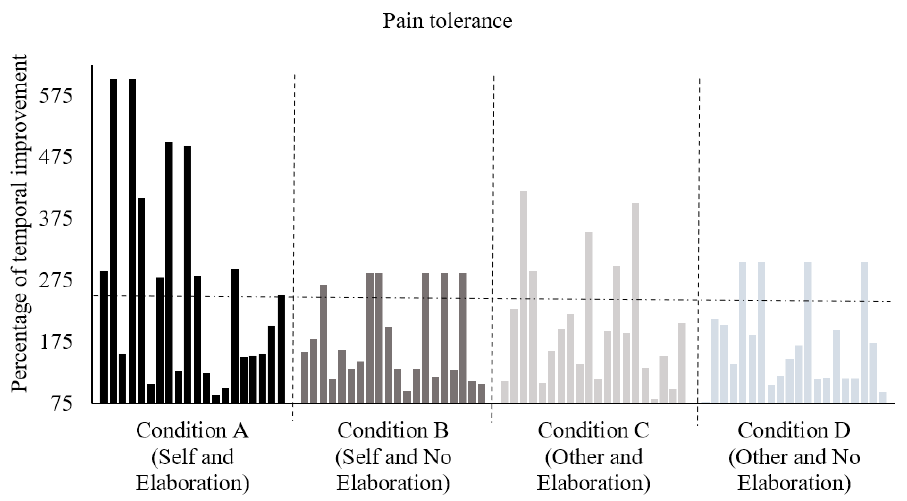
Figure 2. Percentage of temporal improvement in pain tolerance in posttest in relation to pretest for participants of each experimental condition. The horizontal, dashed line highlights improvements above 250% of temporal improvement.